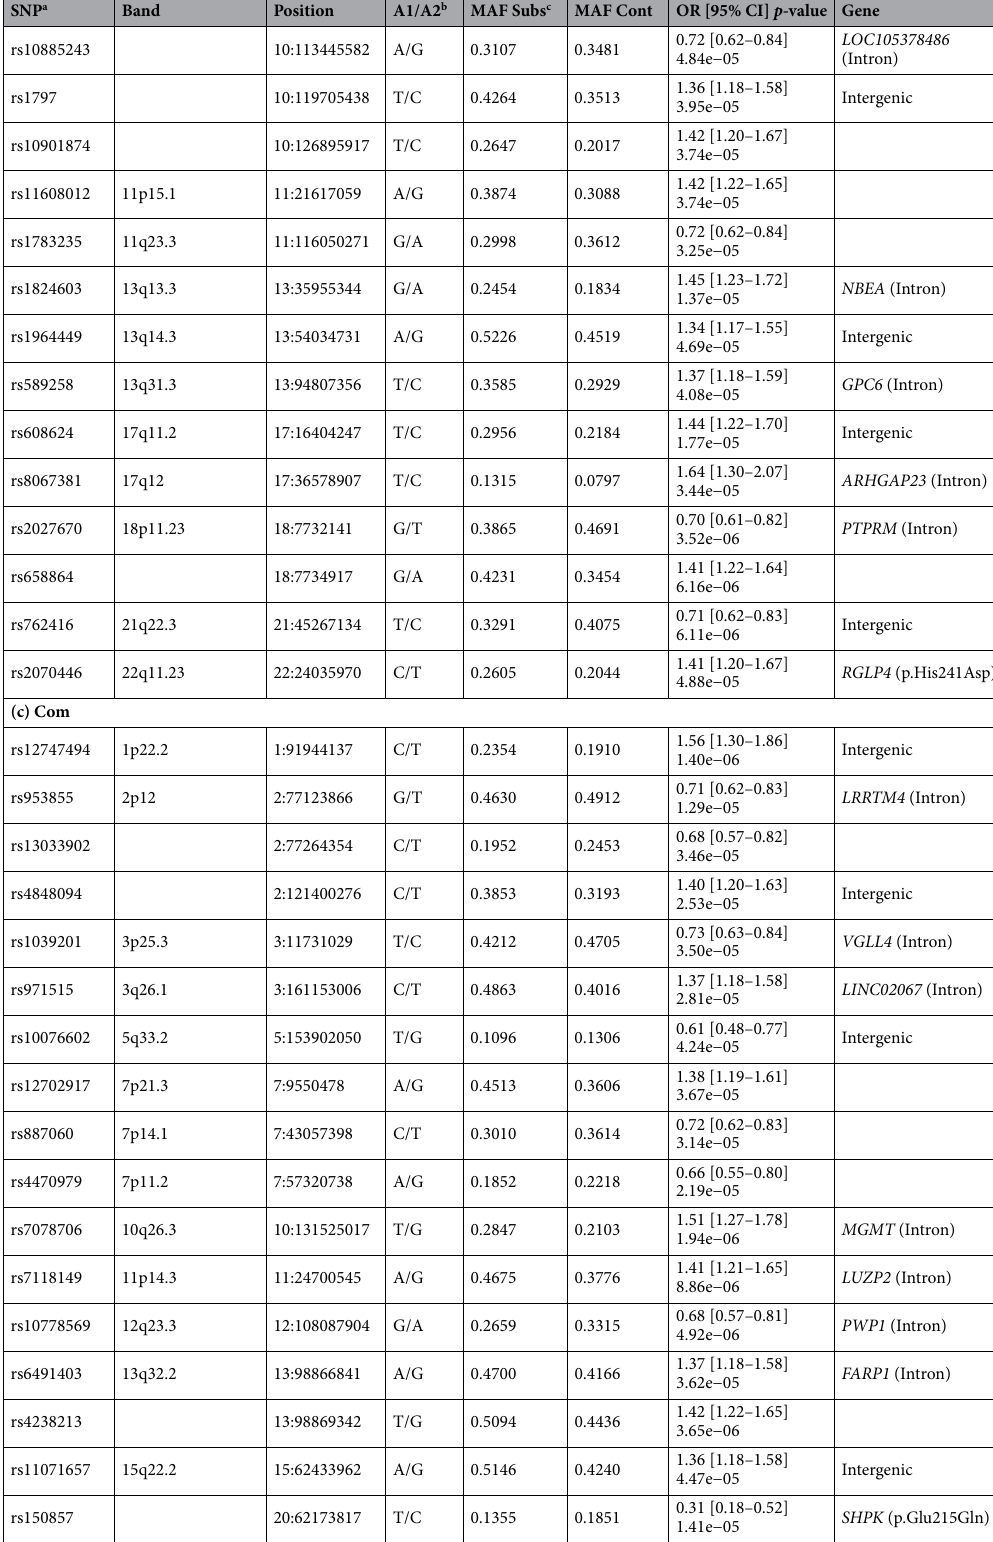
Table 2. Genetic loci associated with Subs , Psych , and Com. a Single-nucleotide variant, dbSNP code. b A1 = effect allele/A2 = no effect allele. c Minor allele frequency of A1 allele. d Effect, in silico predicted effect of the